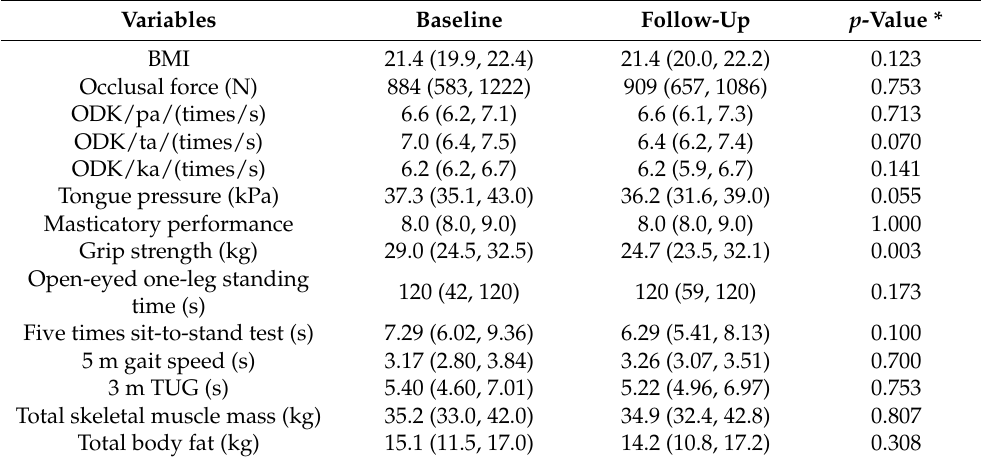
Table 4. Within-group comparison of each endpoint at baseline and follow-up in the exercise group (n =